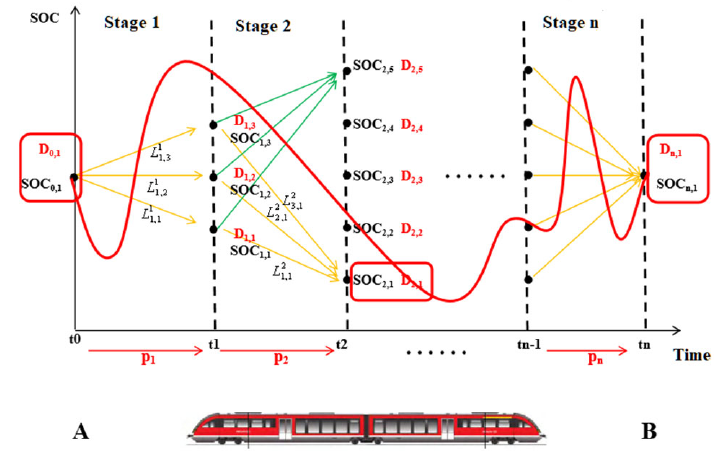
Figure 7. DP basic principle diagram.